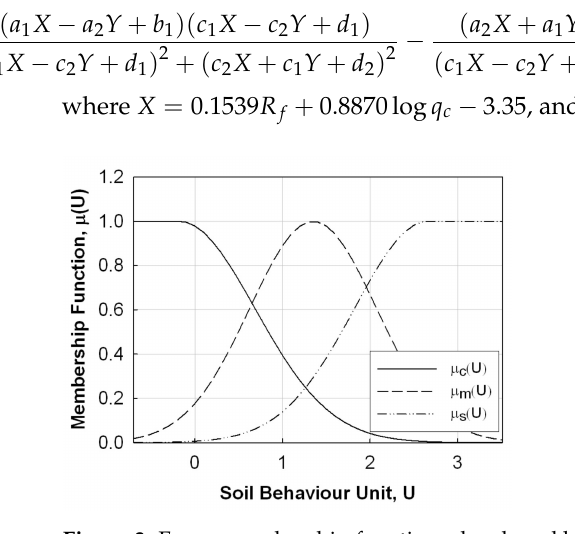
Figure 3. Fuzzy membership functions developed by Zhang and Tumay [7].